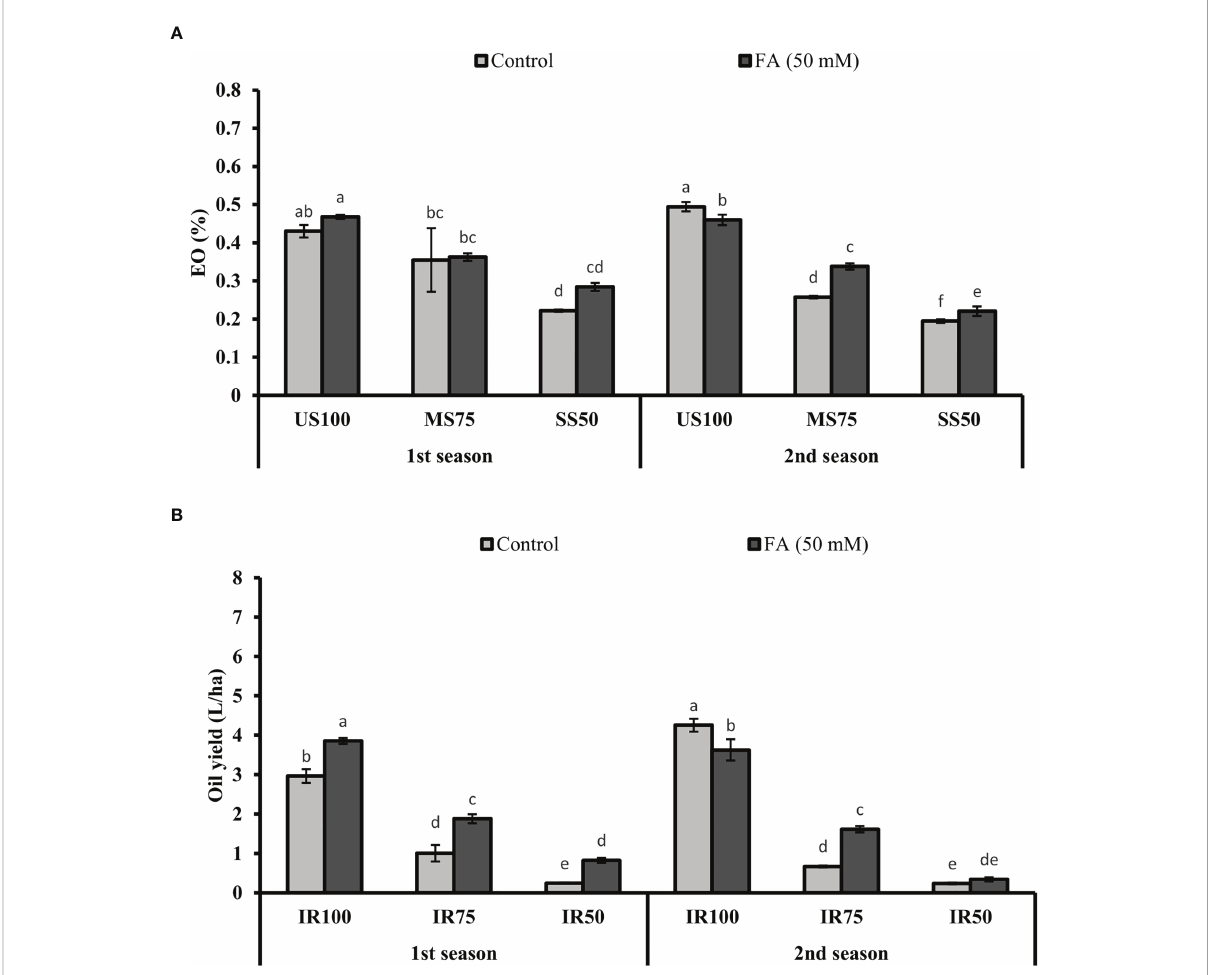
FIGURE 13 Effect of foliar application of folic acid (50 mM) on (A) % essential oil and (B) oil yield in the fi rst and second seasons. The graph values are the mean ± SE of four replicates. The bars exhibited with different letters indicate a signi fi cant difference between samples by least signi fi cant difference ( p ≤